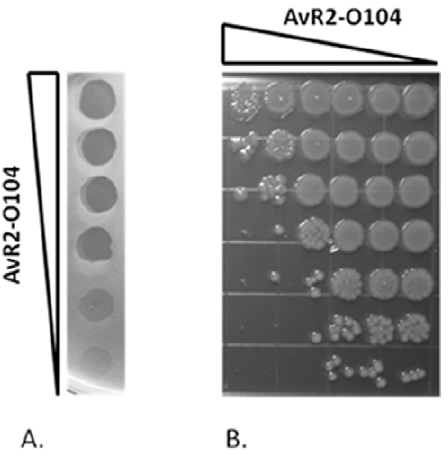
Figure 1. Bactericidal activity of AvR2-O104.1. A. Lawn spot assay of a 5-fold dilution series of AvR2-104 showing zones of killing E. coli strain RM13368. B. Titration survival assay of AvR2-104 on strain RM13368. 10 8 cells were incubated in individual wells of a multi-well plate with 5-fold serial dilutions of pyocin (left to right) for a period of 40 minutes. Survivors are then 10-fold serially diluted (top to bottom) and plated on LB agar to determine the number of surviving colony forming bacteria. By this assay a typical 200 ml preparation of AvR2-104 yields approximately 10 12 killing units total (see Materials and Methods).